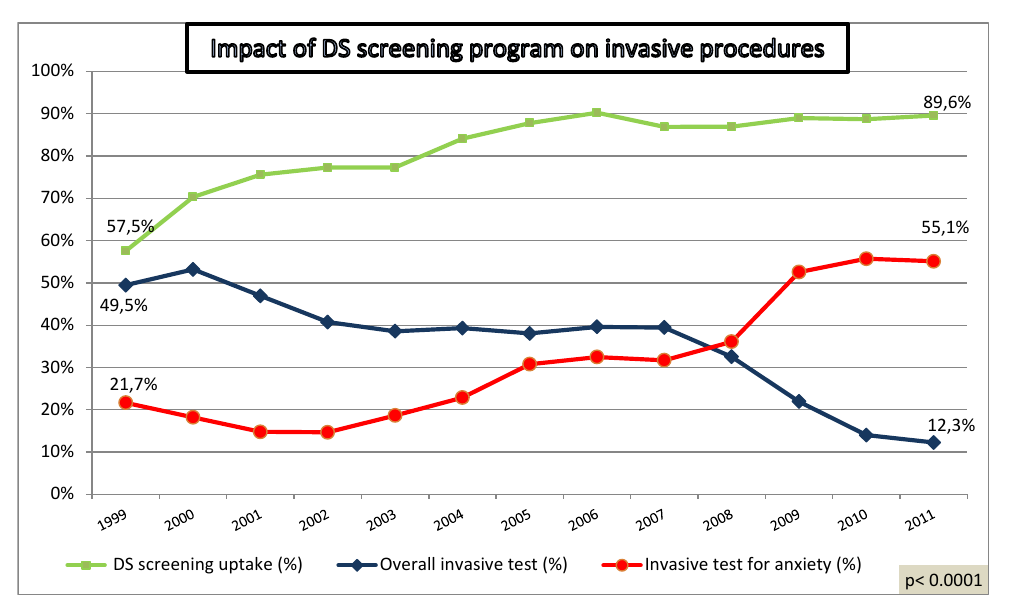
Figure 1. Impact of Down syndrome (DS) screening program on invasive procedures.